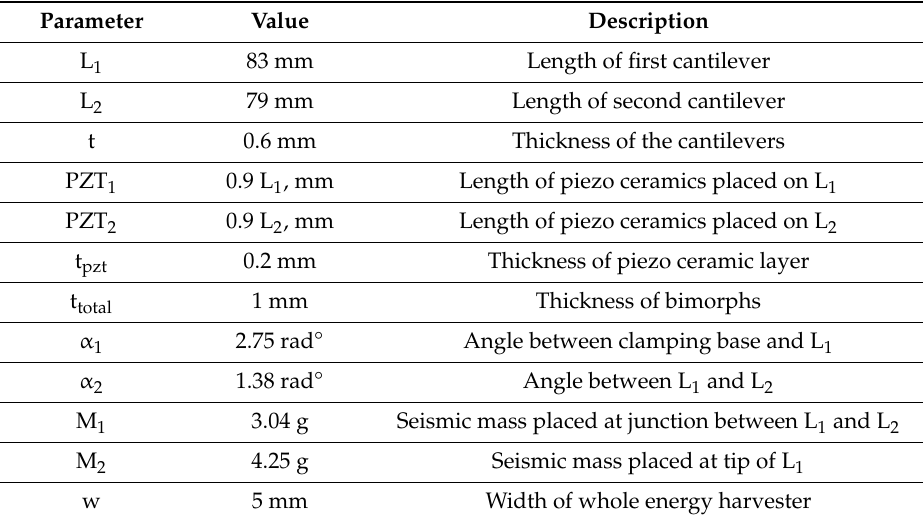
Table 3. Geometrical and physical parameters of the harvester.